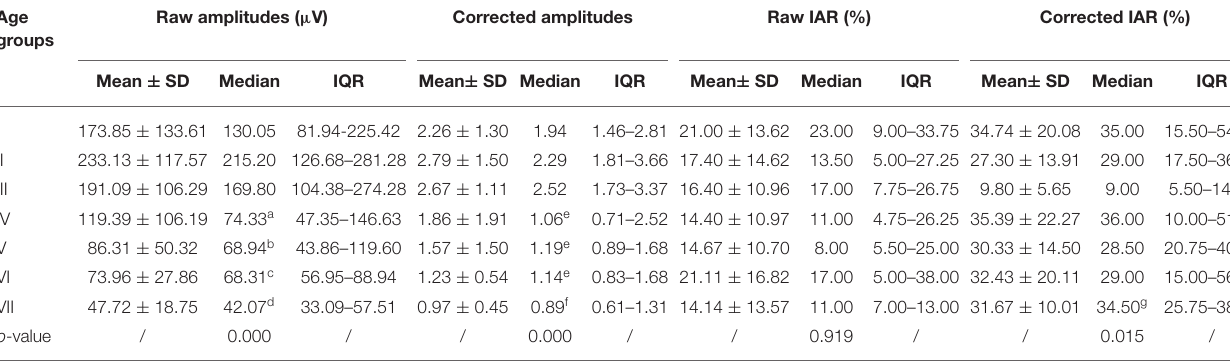
TABLE 3 | Raw amplitudes, corrected amplitudes, raw IAR, and corrected IAR of B81-cVEMP with increasing age. Age groups